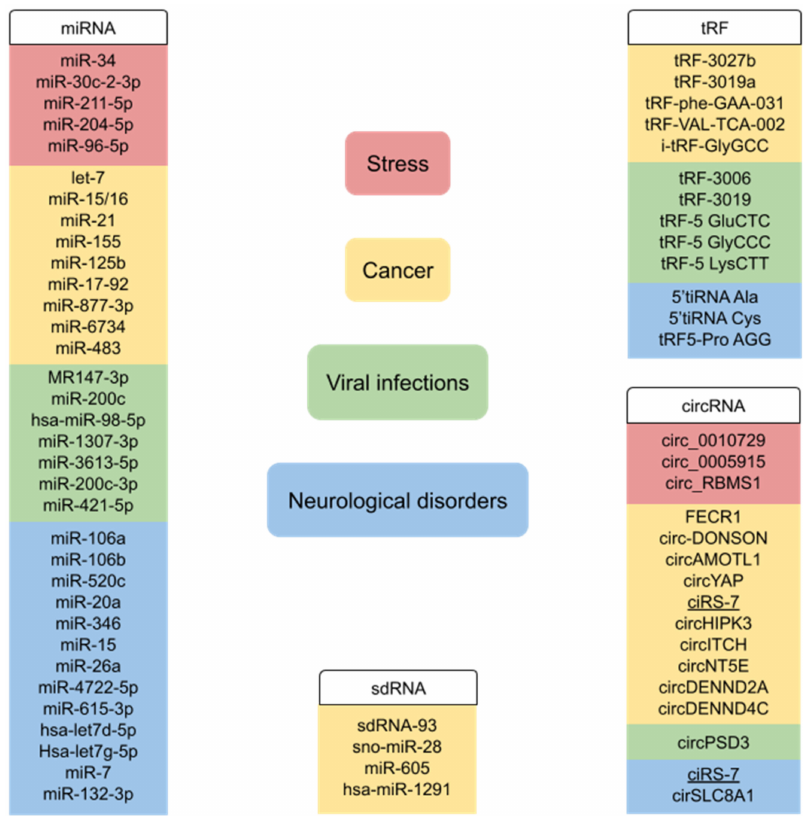
Figure 6. Examples of noncoding RNAs involved in stress-related processes, cancer, viral infections, and neurological disorders. RNAs involved in more than one disease are